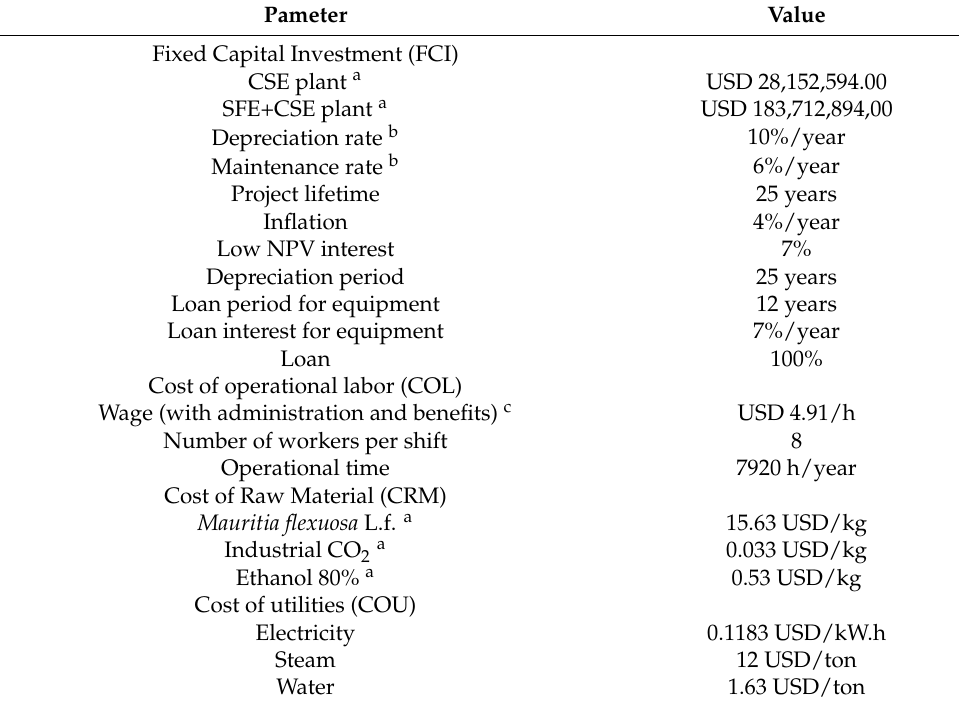
Table 4. Input economic parameters used in SuperPro Designer 9.0 ®